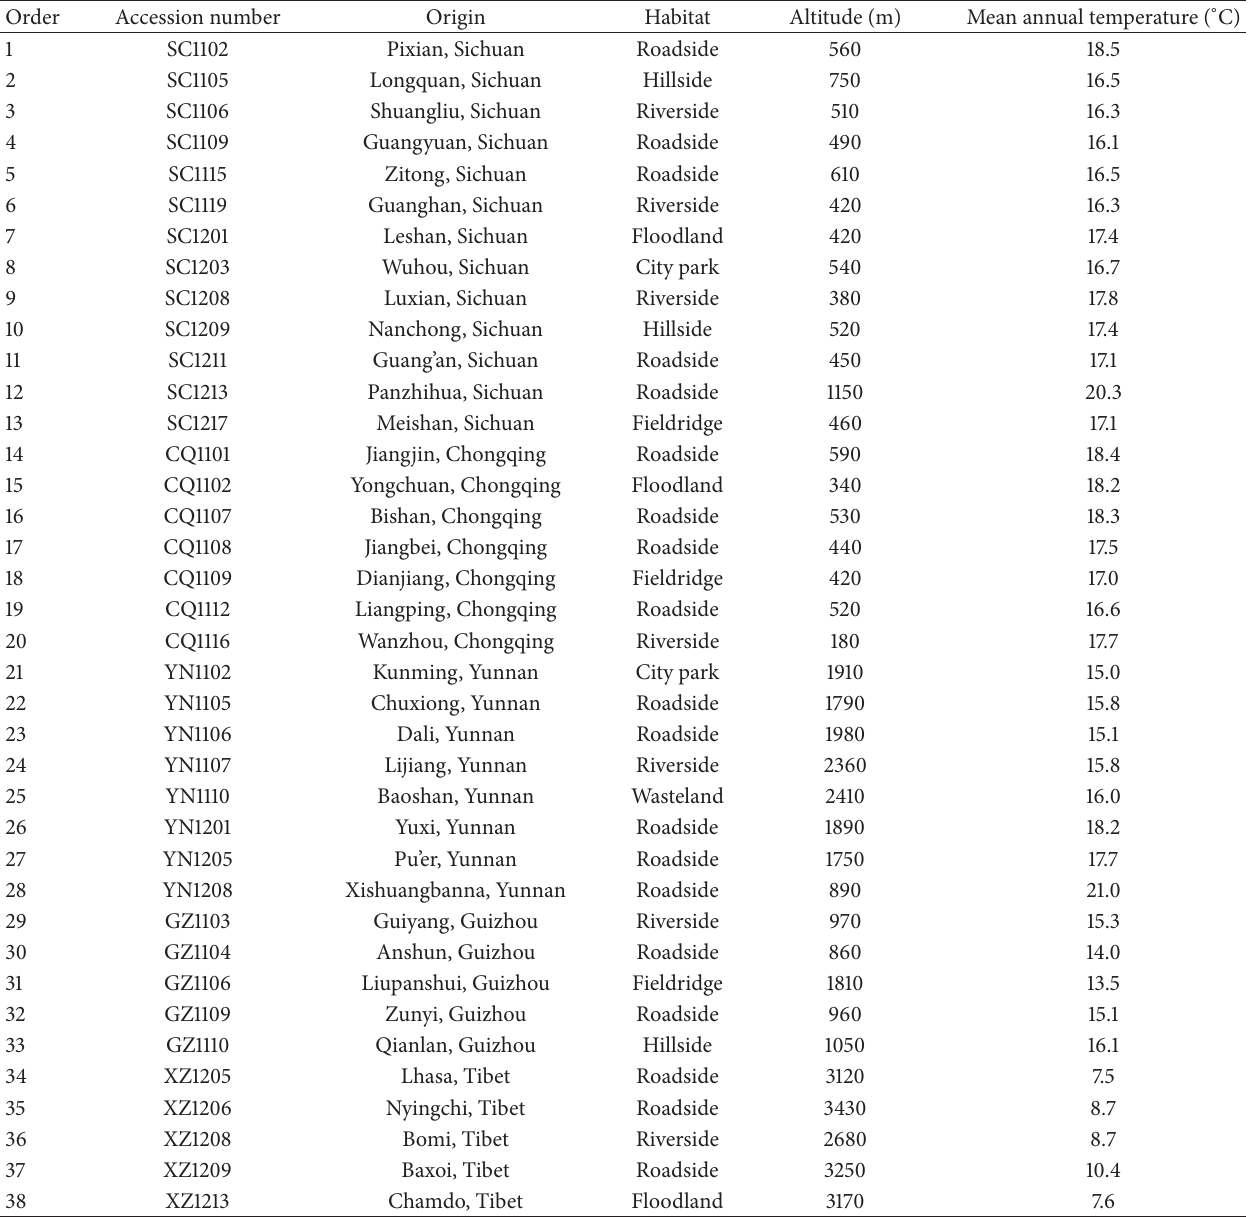
Table 1: Geographical origin of 38 wild C. dactylon accessions used in this